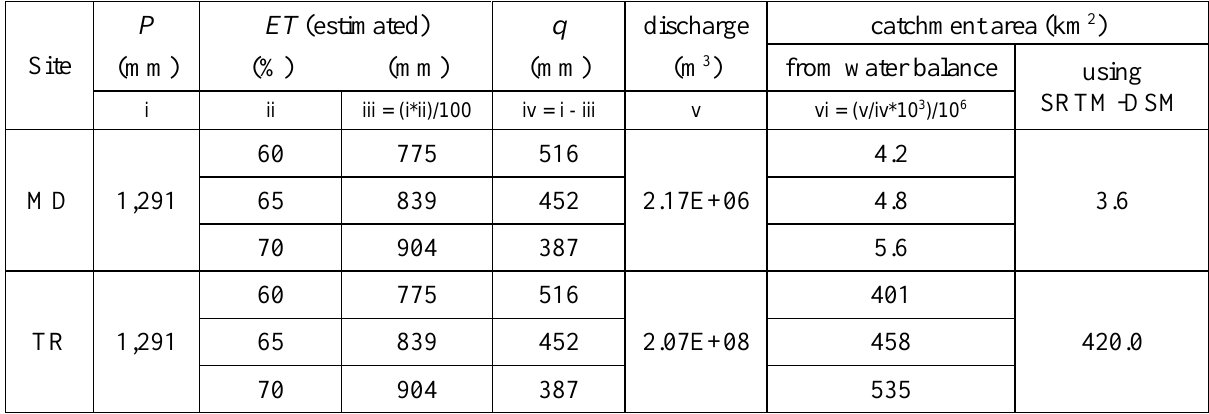
Table 2. Derivation of catchment area estimates, from the water balance for the period 25 May 2012 to 08 February 2013 (259 days). P = total observed rainfall at MD, ET = evapotranspiration, q = runoff depth, discharge = total observed stream discharge. Catchment area estimates derived by spatial analysis of SRTM- DSM data are shown for